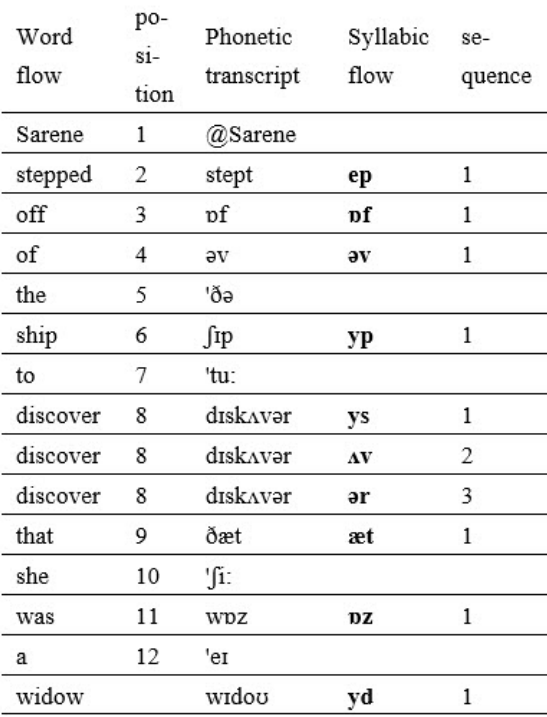
Table 1. Example of decomposition of the sentence “ Sarene stepped off of the ship to discover that she was a widow. ” into VC- biphones – a query